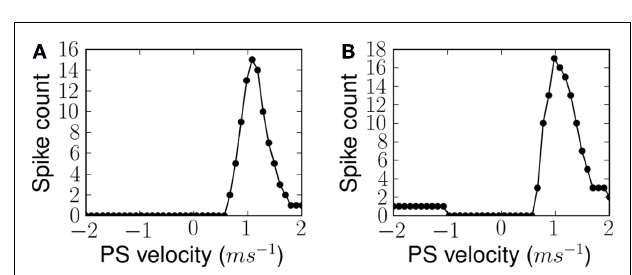
FIGURE 9 | Measured FM sweep tuning curves after exposure to (A) linear and (B) forked stimulus, for ES velocity 1.0ms − 1 in both cases. Response of the network is quantified by the number of output spikes from the population of B 2